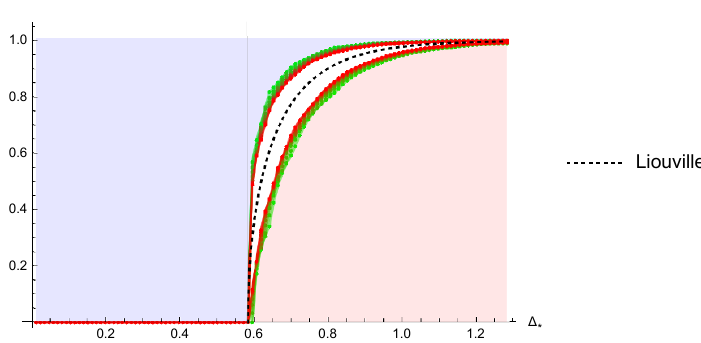
Figure 7 . Bounds on the modular spectral function assuming only scalar primaries and a dimension gap of (cid:1) gap = c (cid:0) 1 for c = 12